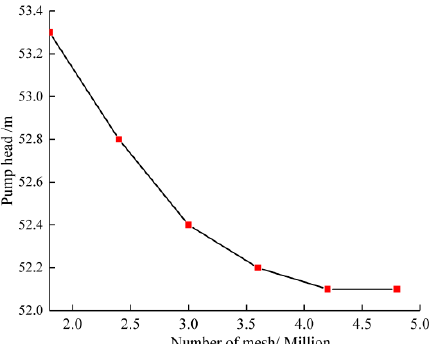
Figure 4. Change curve of the pump head with grid number.